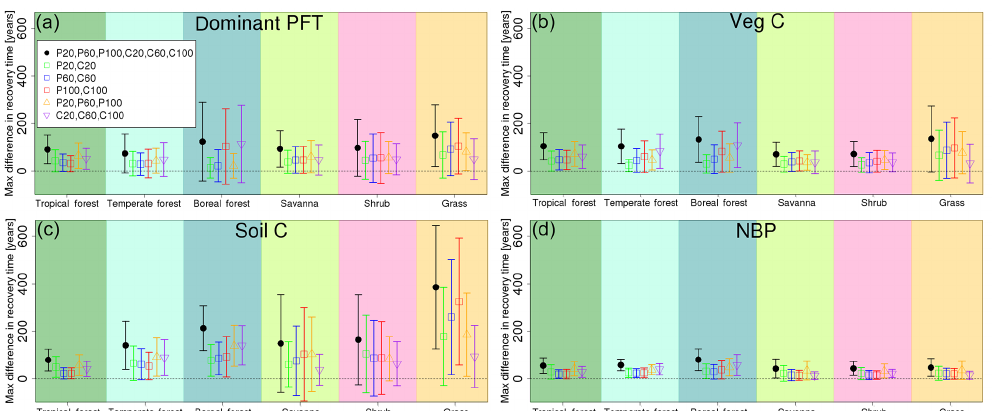
Figure 6. Maximum difference in recovery time (longest recovery time minus shortest recovery time of all selected simulations) for the dominant PFT, vegetation C, soil C, and NBP. Black dots show maximum differences across all six simulations (P20, P60, P100, C20, C60, C100), green squares differences across 20-year pasture and cropland simulations (P20, C20), blue squares differences across 60-year pasture and cropland simulations (P60, C60), red squares differences across 100-year pasture and cropland simulations (P100, C100), orange triangles differences across pasture simulations (P20, P60, P100), and purple triangles differences across cropland simulations (C20, C60, C100). Background colors indicate associated biomes, arrows one standard deviation, and the dashed line 0 years’ difference. Thus, the black dots show the sensitivity of recovery times to LU history across all simulations for each biome. The red, blue and green squares indicate the relative contribution of LU type for a specific LU duration to this sensitivity, and the orange and purple squares indicate the relative contributions of pasture and of cropland duration. For example, if recovery times for one variable in one grid cell were to be 50, 60, 65, 90, 100, 110 years (for P20, P60, P100, C20, C60, C100), the maximum difference in recovery time across all simulations (black) would be 60 years, across the 20-year simulations (green) 40 years, across the 60-year simulations (blue) 40 years, across the 100-year simulations (red) 45 years, across the pasture simulations (orange) 15 years and across the cropland simulations (purple) 20